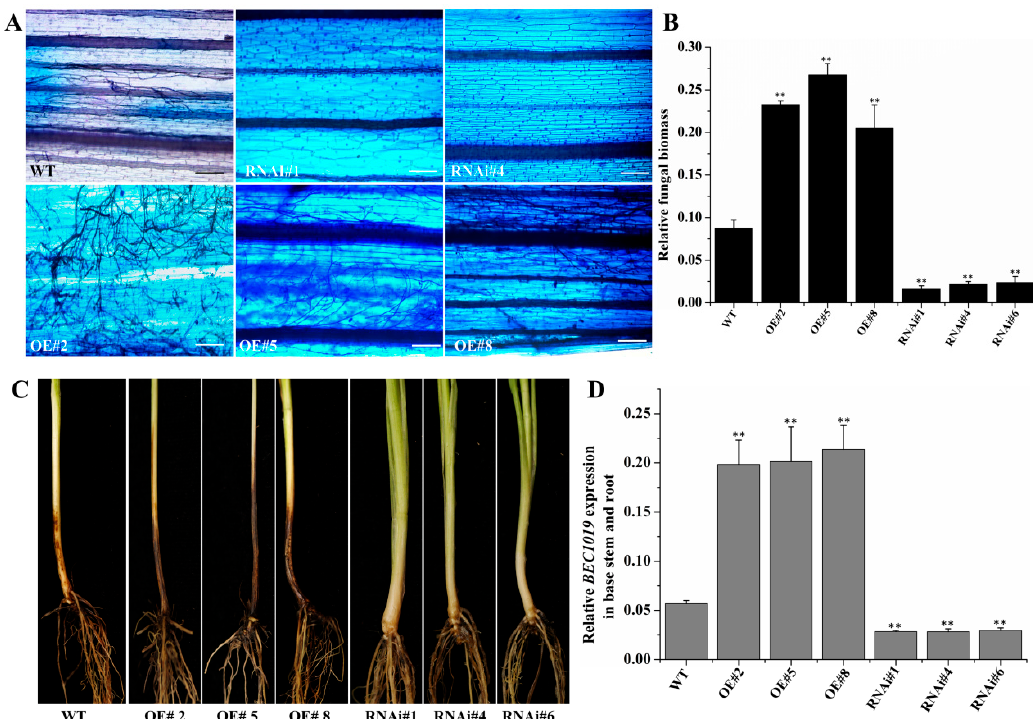
Figure 4. Overexpression of BEC1019 in Zhoumai 26 wheat increased susceptibility to the necrotrophic pathogen Gaeumannomyces graminis var. tritici ( Ggt ), whereas silencing BEC1019 decreased susceptibility to Ggt . ( A ) Macroscopic responses to Ggt infection on the stems and roots of BEC1019 -overexpressing and RNAi lines and wild-type control plants. ( B ) Relative Ggt biomass of control wheat and BEC1019 overexpressing and RNAi plants. ( C ) Microscopic analysis showing the growth of Ggt hyphae on the stems of wild-type plants and BEC1019 -overexpressing and RNAi plants after inoculation. Scale bar = 25 µm. ( D ) Transcript levels of BEC1019 in Ggt -infected base stems and roots of overexpressing and RNAi transgenic plants. Double asterisks indicate significant differences relative to the control plants ( p ≤ 0.01, according to t -tests).